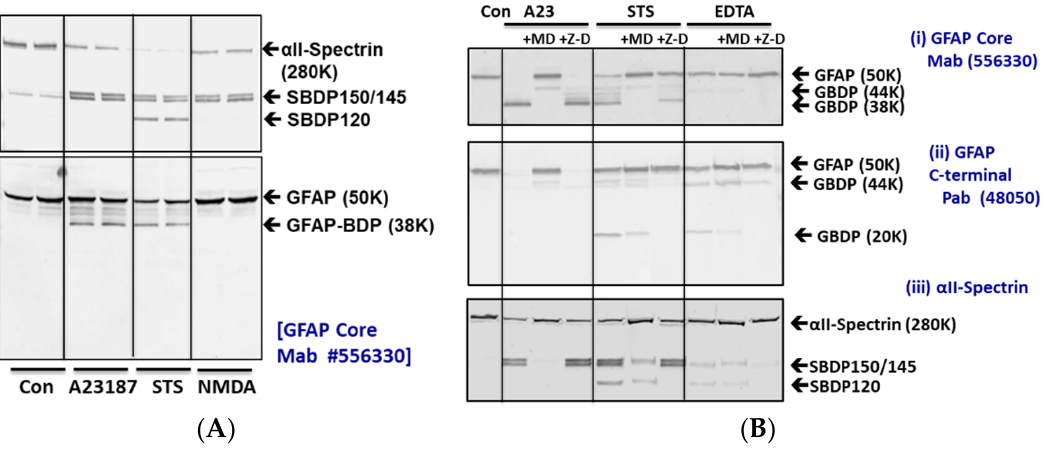
Figure 1. GFAP proteolysis versus αII-spectrin breakdown in cerebrocortical neuron-astroglial mixed culture (CTX) after subjecting to cytotoxin challenges (24 h). ( A ) CTX was subjected to A23187, STS, or NMDA treatment for 6 h. Cell lysate probed with αII-Spectrin or GFAP core Mb. ( B ) CTX treated with A23187, STS, and EDTA for 24 h in the absence or presence of calpain inhibitor MDL-28170 or pan-caspase inhibitor Z-D-DCB. Cell lysate probed with αII-Spectrin or GFAP core MAb or GFAP C-terminal PAb. Blots are representative of four separate experiments. CTX subjected to STS treatment in the absence or presence of caspase-6 inhibitor Z-IVED-FMK or with calpain inhibitor MDL-28170.